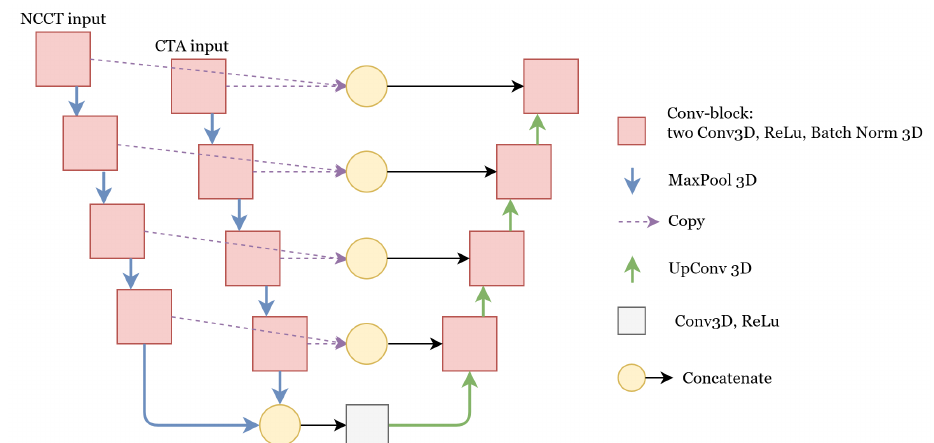
Figure 2. U-Net with two encoders where the features are combined using concatenation. The details of the Conv-block, MaxPool, and UpConv operations are similar to the U-Net with one encoder. For other feature fusion methods, namely add and weighted-sum, the concatenate operation was replaced by addition and weighted-sum,